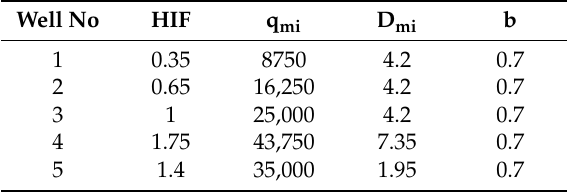
Table 5. Values of different parameters utilized to calculate gas production.